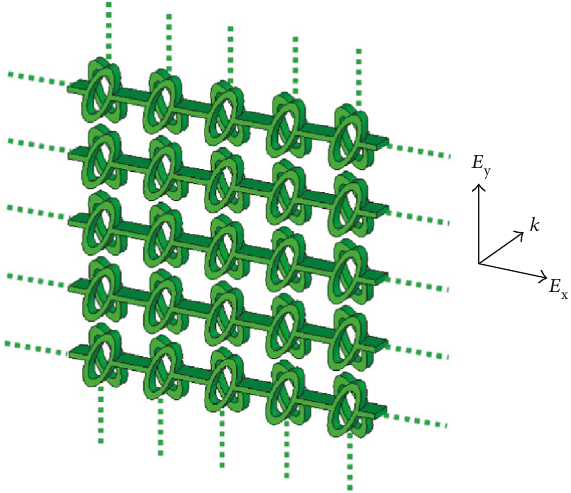
Figure 1: Perspective view of the all-dielectric metasurfaces with connected dielectric resonators along the x